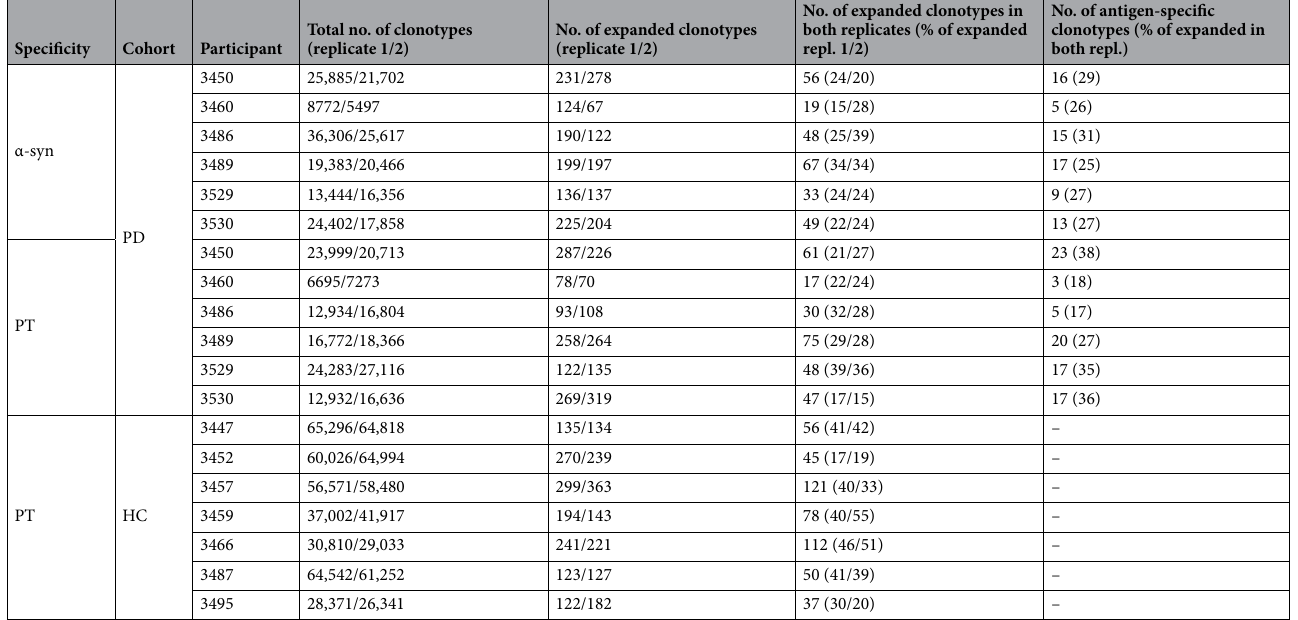
Table 2. Clonotypes expanded upon stimulation with α-syn or PT peptides.